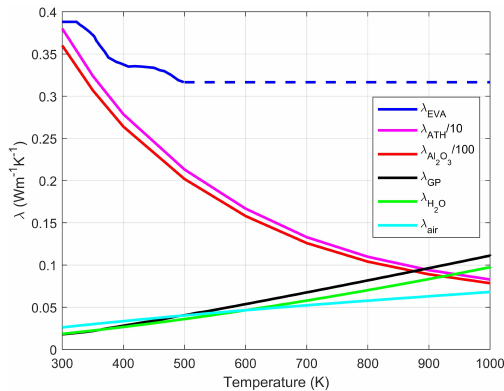
Figure 12. Conductivities of the constituents, as functions of